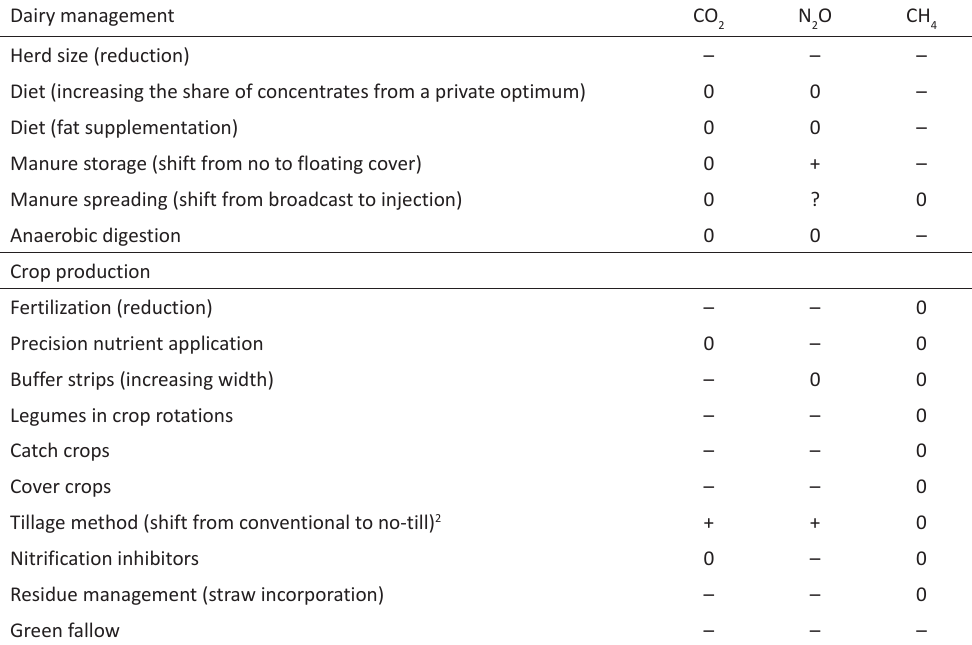
Table 1. Mitigation measures directly affecting GHGs and the direction of change in clay soil for each pollutant in boreal